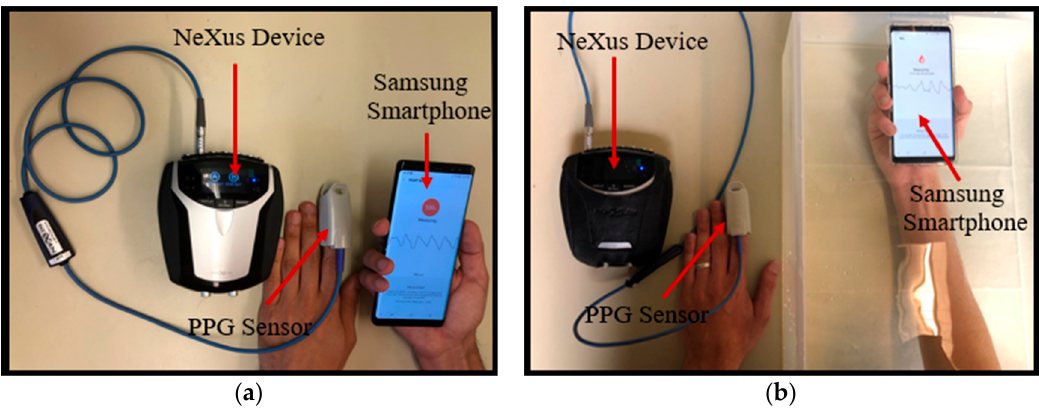
Figure 2. Data acquisition in dry and underwater environments. ( a ) Dry environment: the Samsung Galaxy Note8 PPG sensor is covered with the index finger of the right hand while the PPG sensor of the NeXus-10 MKII device encloses the index finger of the left hand; and ( b ) underwater environment: the Samsung Galaxy Note8 PPG sensor is covered with the index finger of the right hand while the hand is immersed in the transparent bucket filled with water. The PPG sensor of the NeXus-10 MKII device encloses to the index finger of the left hand.